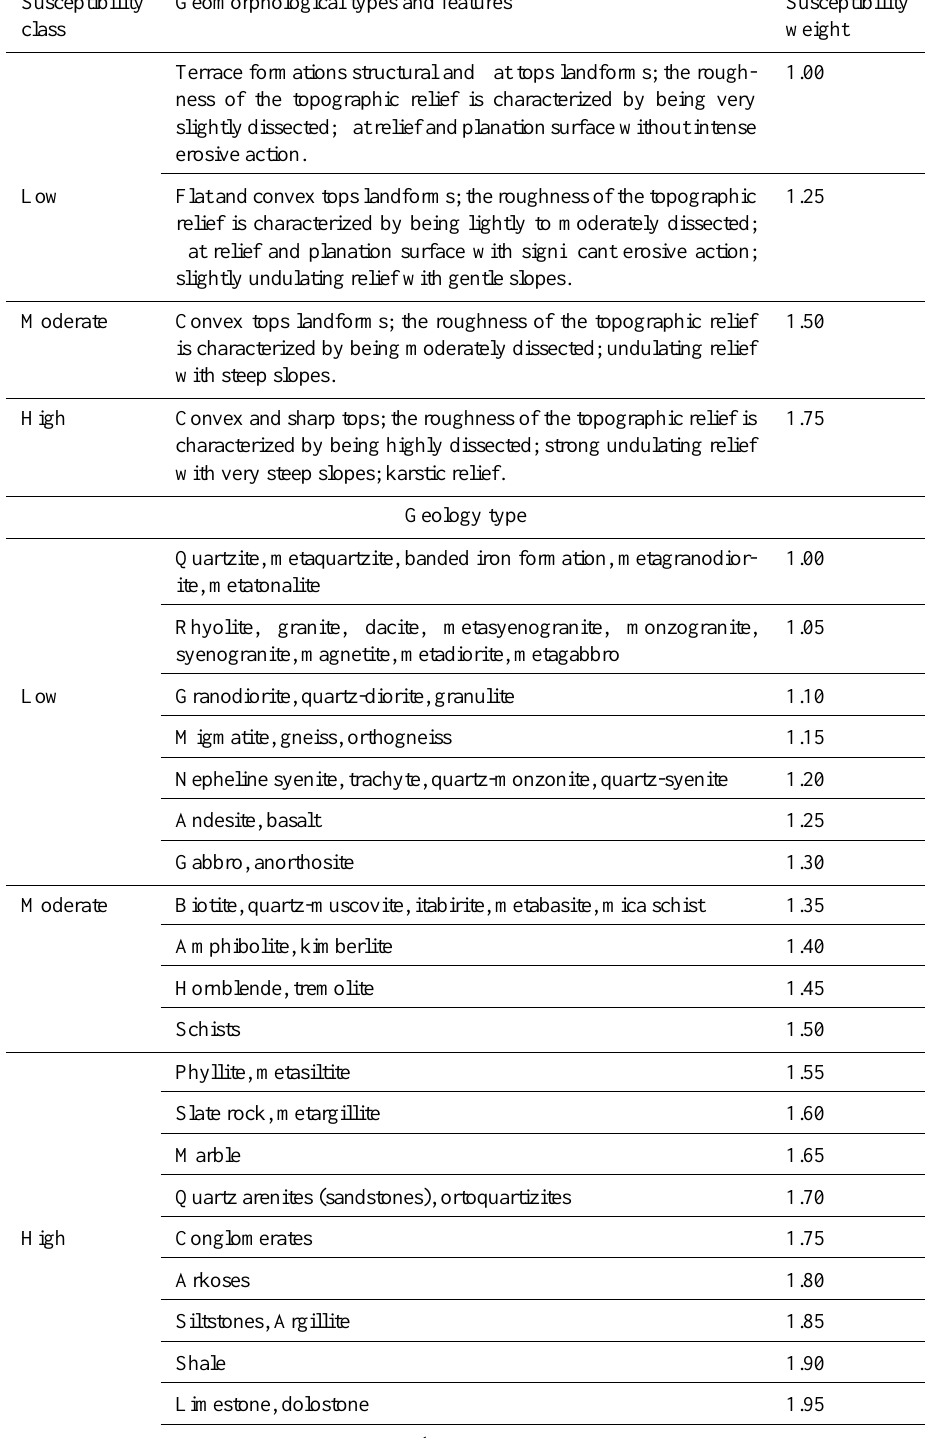
Table 3. Classes and weights of parameters used for environment quality